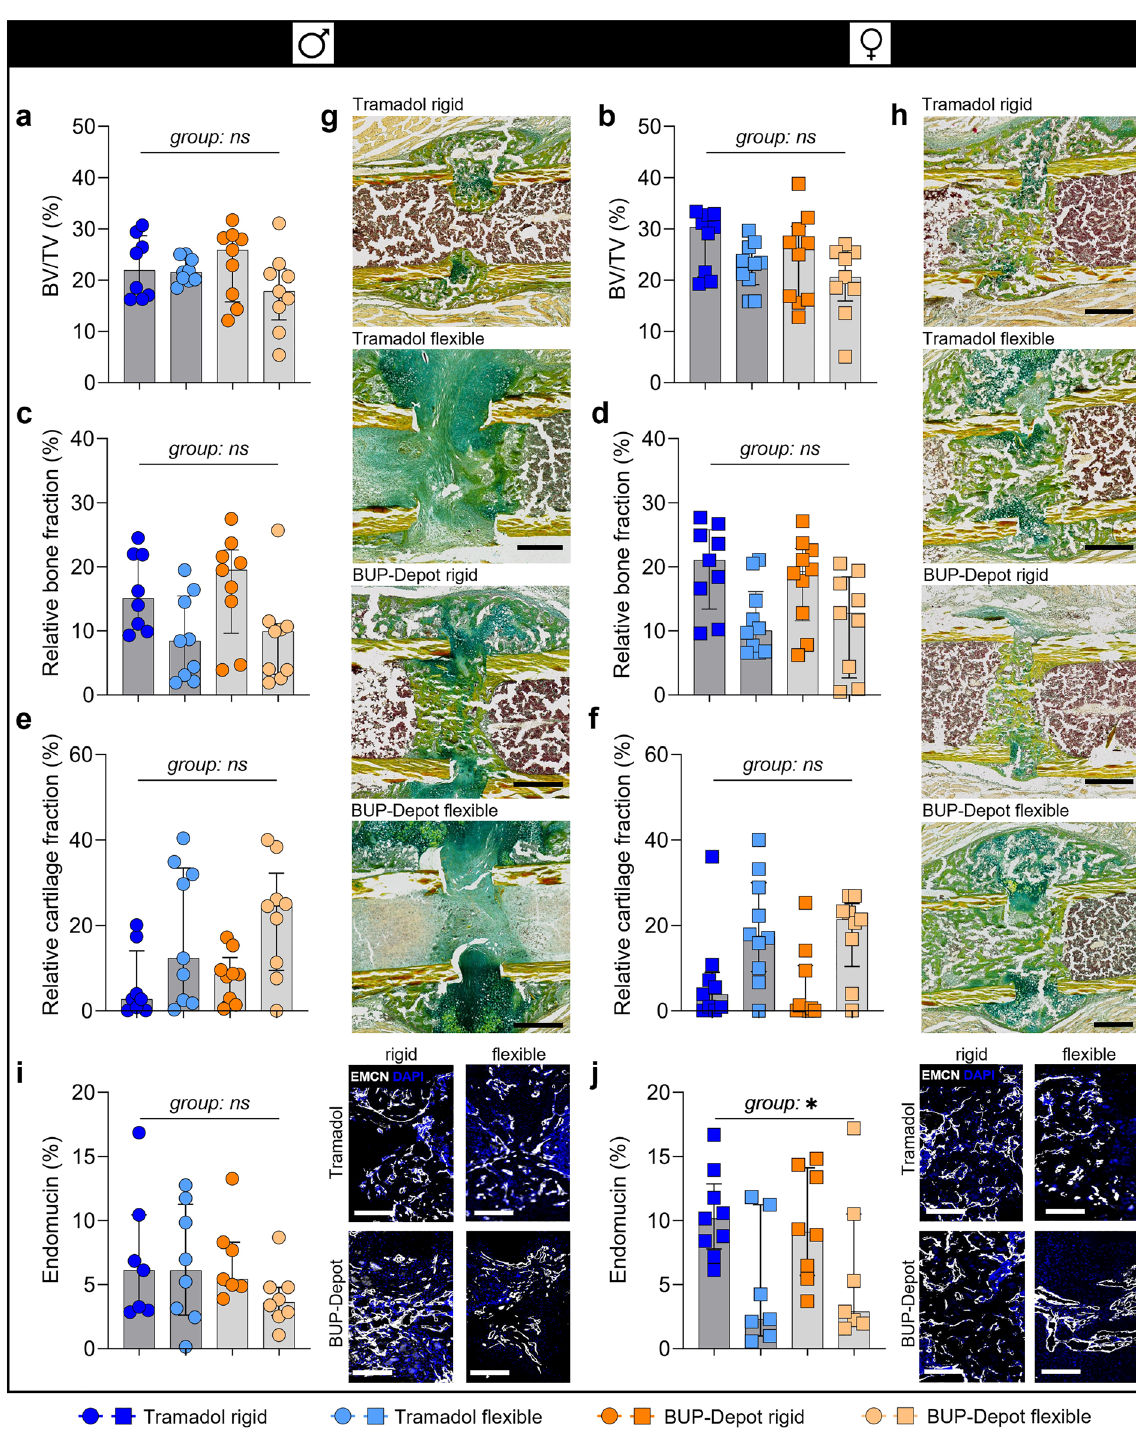
Figure 6. Analgesic regimes did not negatively affect fracture healing outcome at day 14, while the different fixations led to differences in new bone formation. ( a,b ) Relative bone volume (BV/TV) (%), ( c,d ) relative bone fraction (%) and ( e,f ) relative cartilage fraction (%). ( g,h ) Exemplary images of the Movat’s pentachrome staining: yellow = mineralized bone, green = cartilage, magenta = bone marrow; scale bar 500 µm. ( i,j ) Immunofluorescence staining of vessel formation (Endomucin) including quantification and exemplary images; scale bar 200 µm. All graphs show median with interquartile range for n = 8–10 ( a–h ) and n = 6–9 ( i,j ). To determine group differences, Kruskal–Wallis test and Dunn’s post hoc test with Bonferroni correction were performed; exact p -values are listed in Table S11–S13.1; * p <